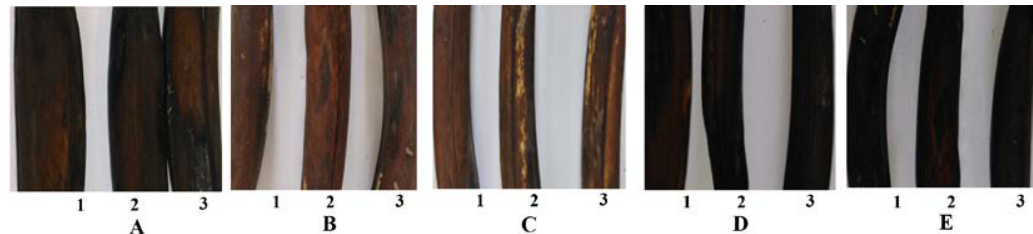
Fig. 3.5. 19 th day of banana sample treated with different treatment A. Sodium alginate B. Starch C. Aloe vera D. Gelatin E. Glycerol